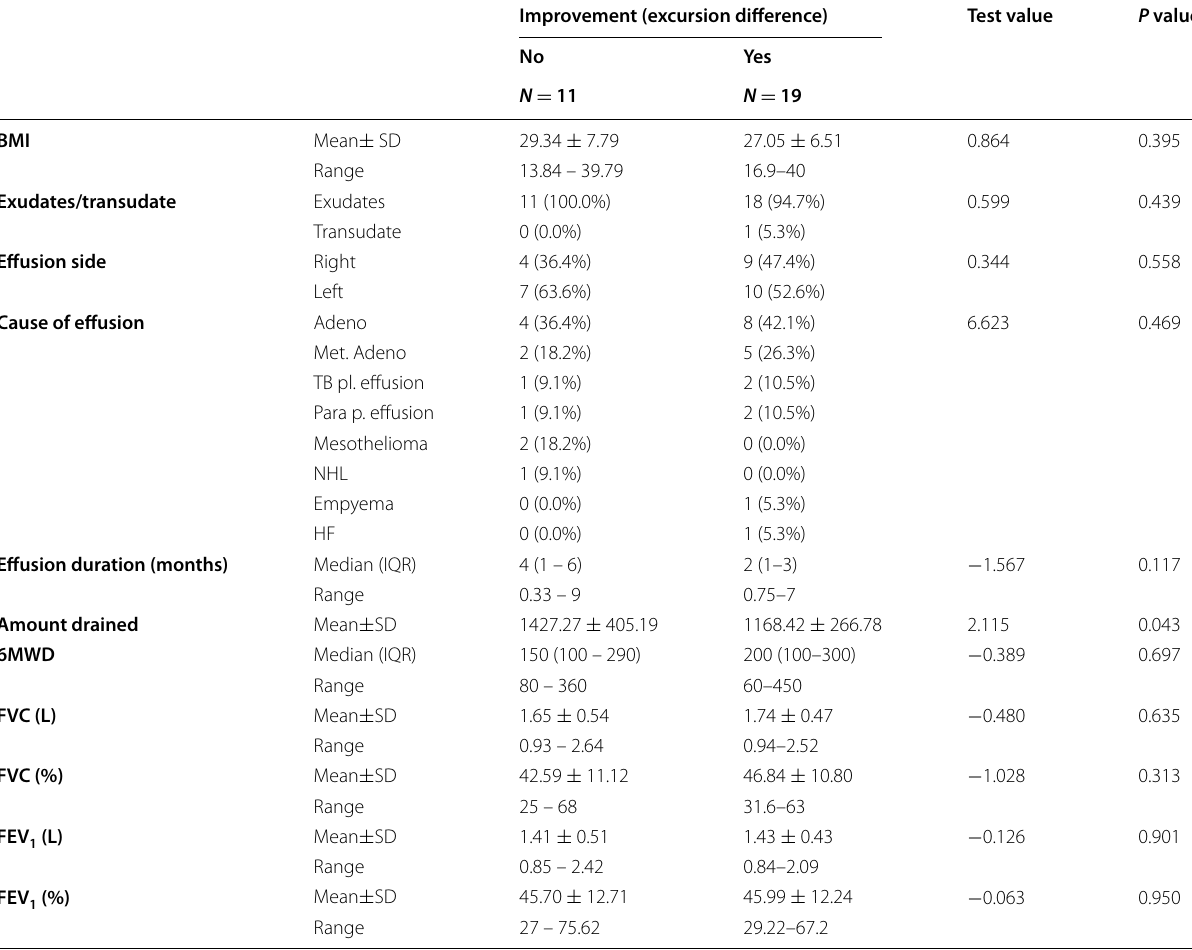
Adeno adenocarcinoma, Met. adeno metastatitc adenocarcinoma, TB. pl. effusion tuberculous pleural effusion, para p.effusion parapneumonic effusion, MWD minute walk distance, FVC forced vital capacity, FEV 1 forced expiratory volume in the first second, FEF forced expiratory flow